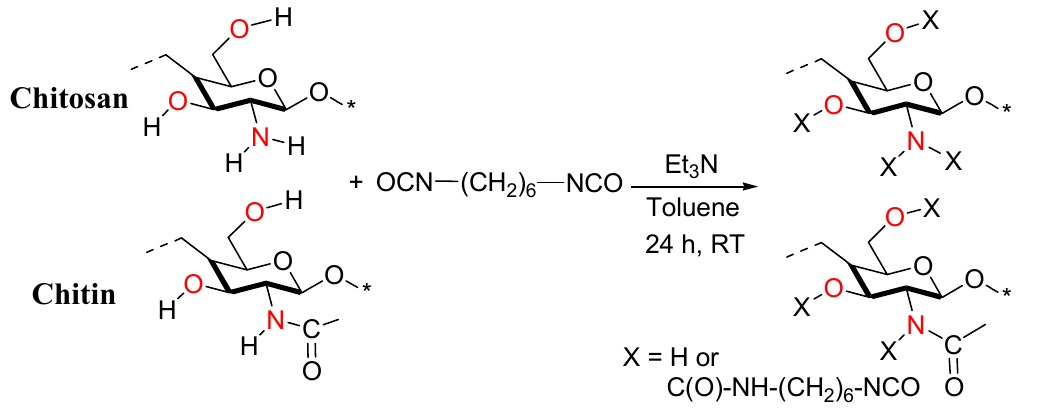
Figure 4. Reaction of chitosan and chitin with hexamethylene diisocyanate